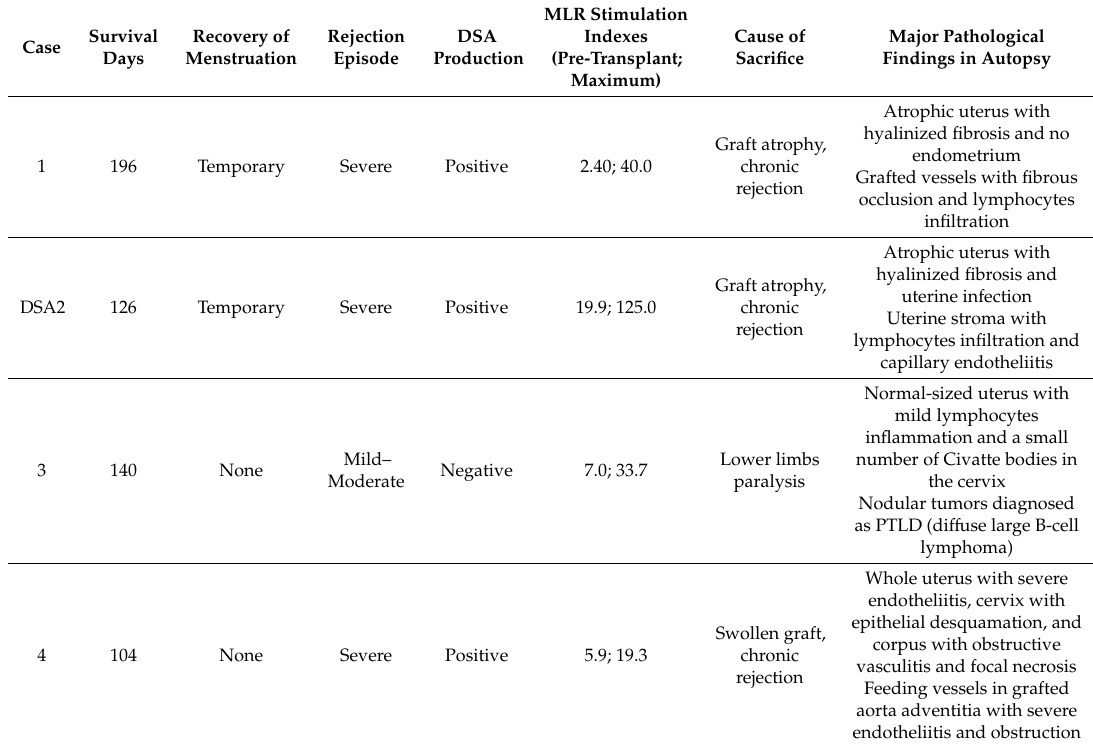
Table 1. Summary of overall outcomes in